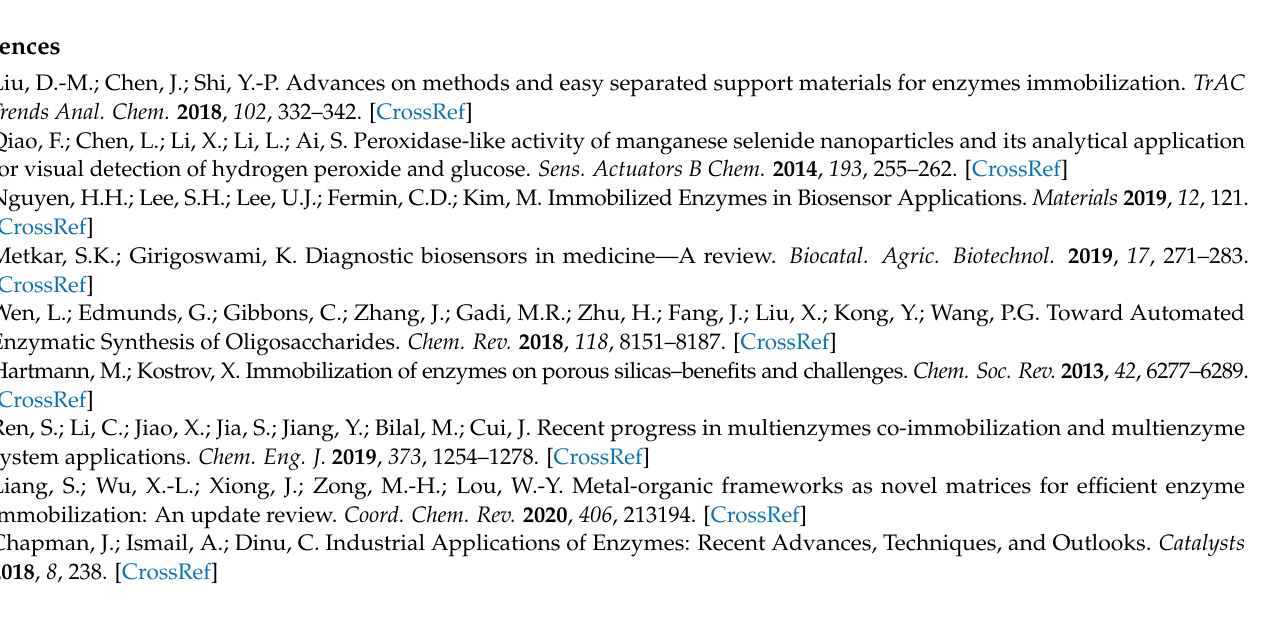
Figure S1: Morphology of FeS 2 ; Figure S2: FTIR absorption spectrum of Gox; Figure S3: Elemental distribution of FeS 2 /CS@Gox; Figure S4: The Color of FeS 2 /CS@Gox under UV light; Figure S5: Hy- droxyl radicals produced by FeS 2 ; Figure S6: Selectivity of FeS 2 to H 2 O 2 ; Figure S7: Selectivity of FeS 2 /CS@Gox to